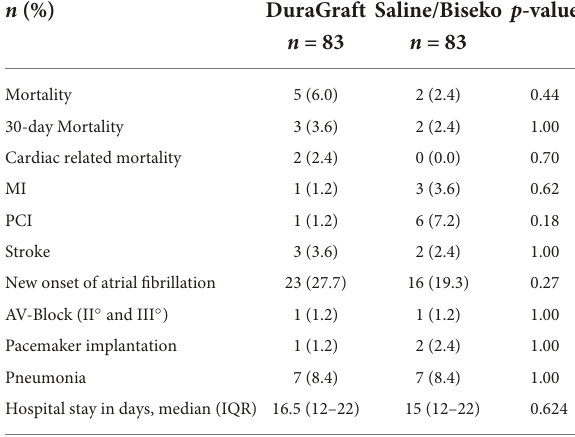
TABLE 5 Cardiac adverse events after matching over the median follow-up of 4 (IQR 0–22)